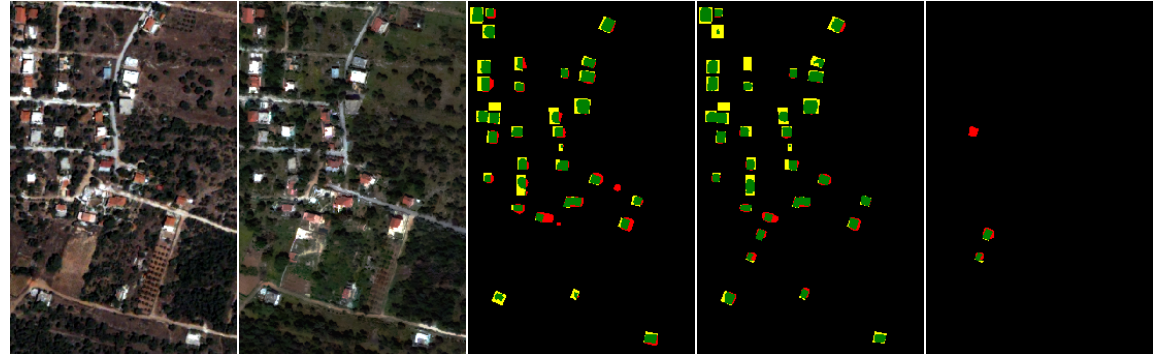
Figure 4. Qualitative results of multi-task L-UNet with 5 dates, for a region of Attica VHR testing part. From left to right: RGB image of 2006, RGB image of 2011, building predictions of 2006, building predictions of 2011, building change predictions. [ Green : True Positives, Black : True Negatives, Red : False Positives, Yellow : False